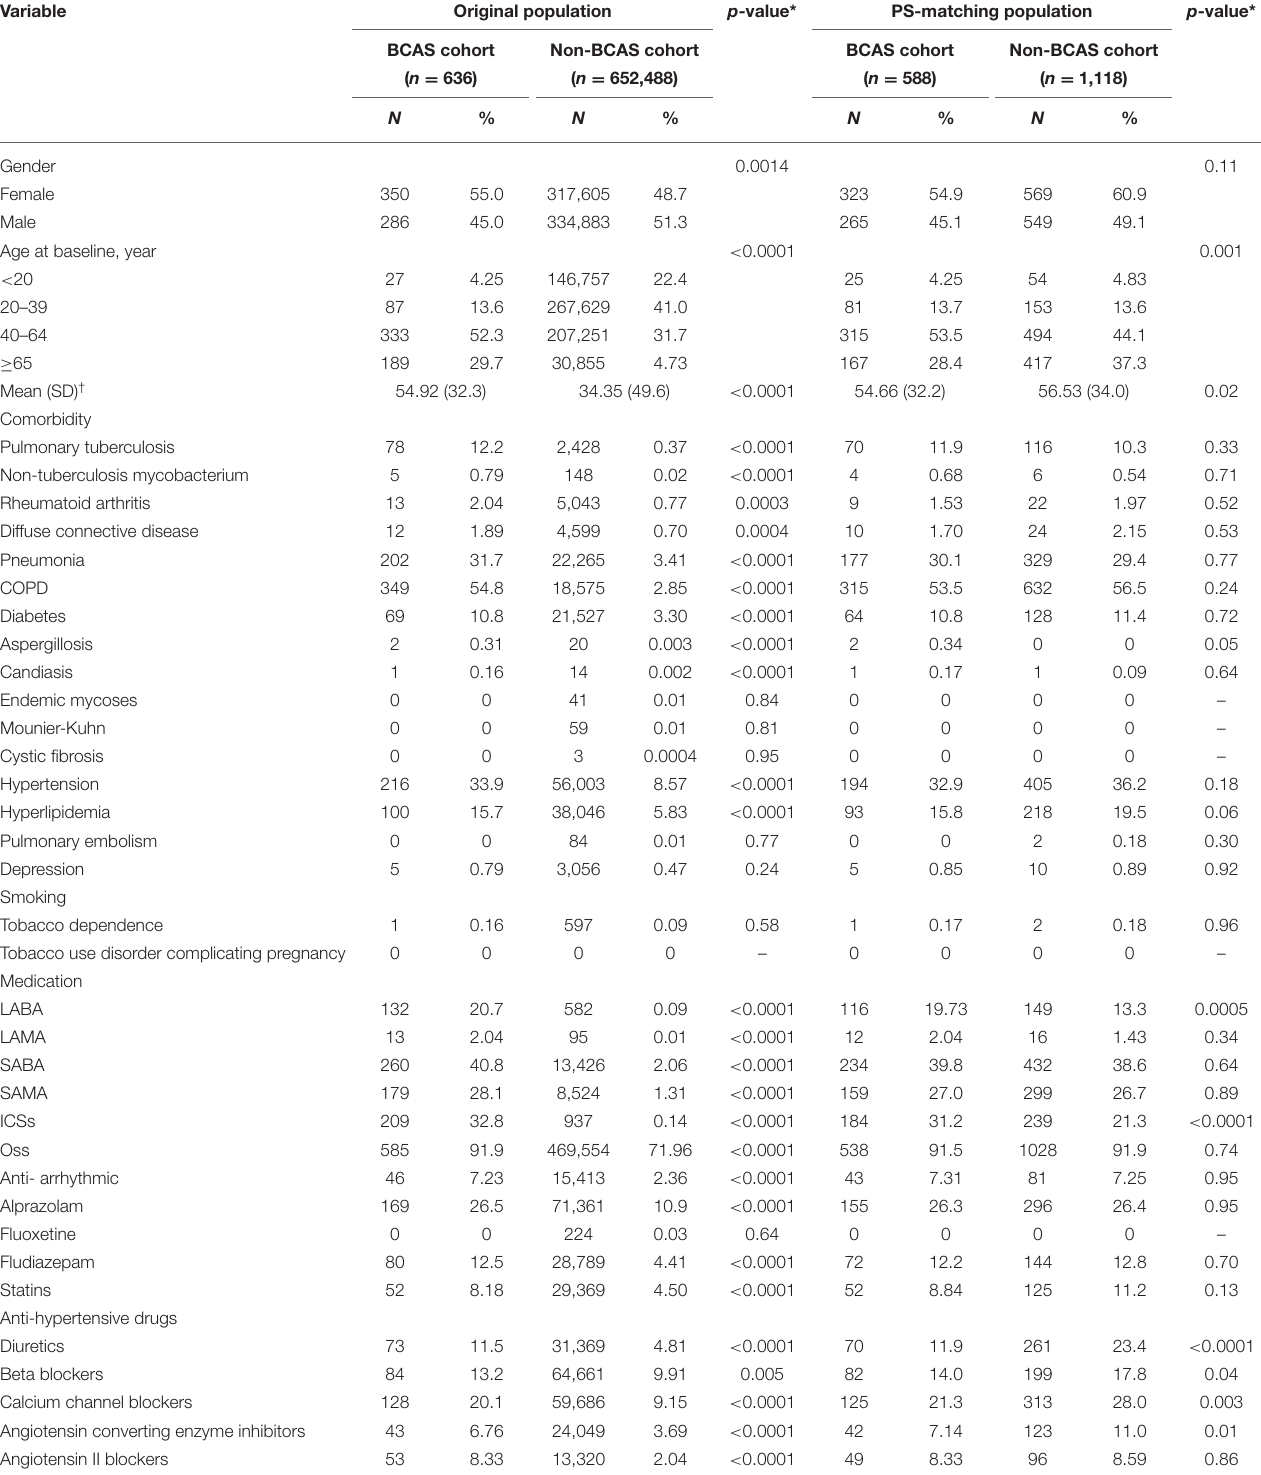
TABLE 1 | Baseline characteristics of study population before and after matching based on propensity scores between two cohorts.